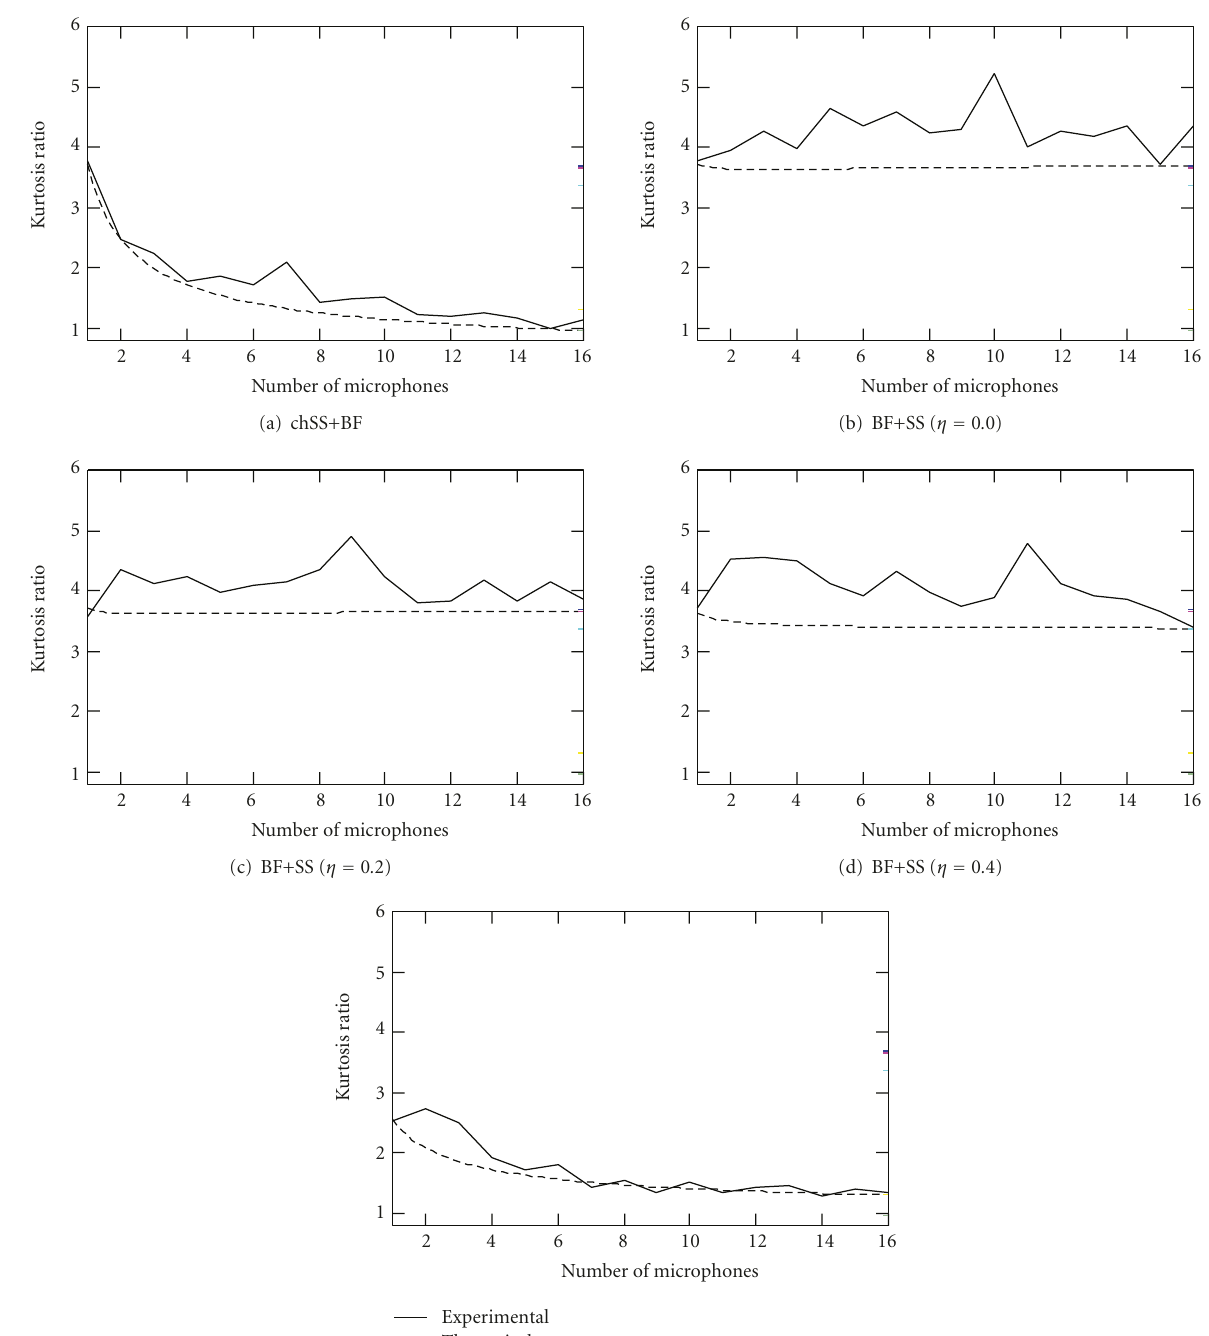
Figure 19: Comparison between experimental and theoretical kurtosis ratios for super-Gaussian input signal.